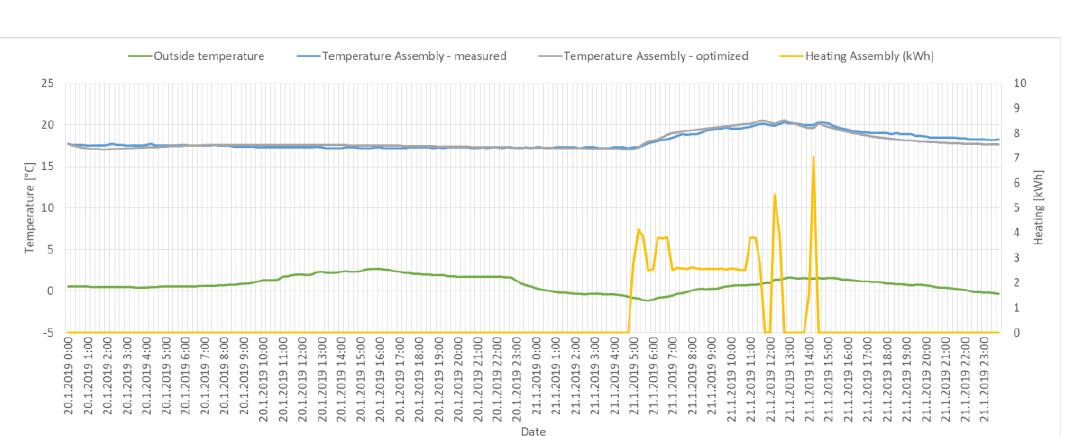
Figure 11. Results of initial model with Winter 2-3 scenario.